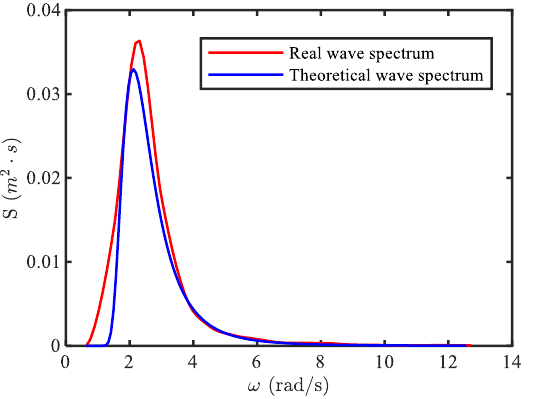
Figure 5. Comparison of wave spectra of irregular waves based on the PM spectrum.